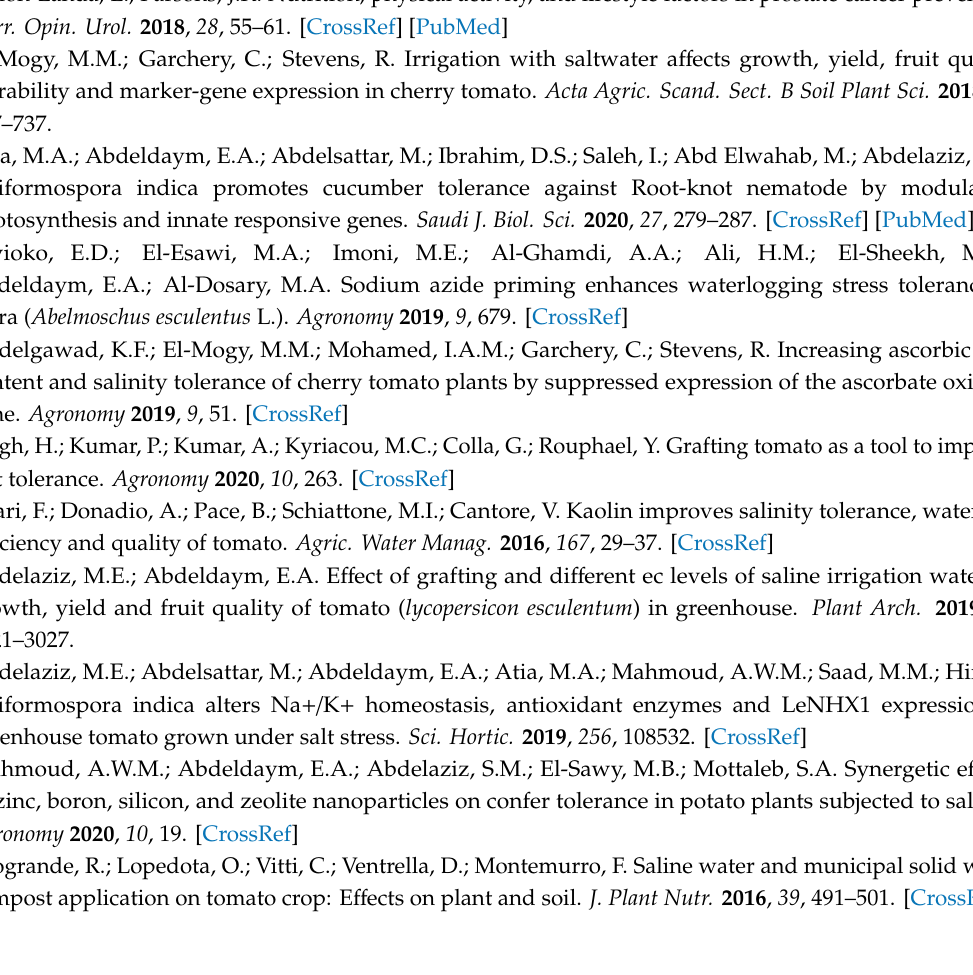
Table S1: Conserved DNA sequence targets and primer sequences and details title, Table S2: Primer code and primer sequences of the SCoT primers, Table S3: E ff ect of salinity treatments, rootstocks, and their interactions on yield and its